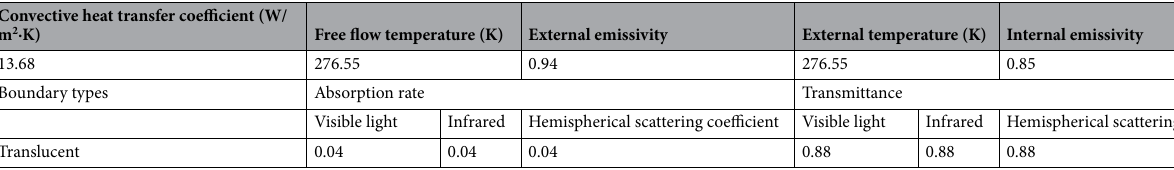
Table 5. Boundary settings of the glass cover.